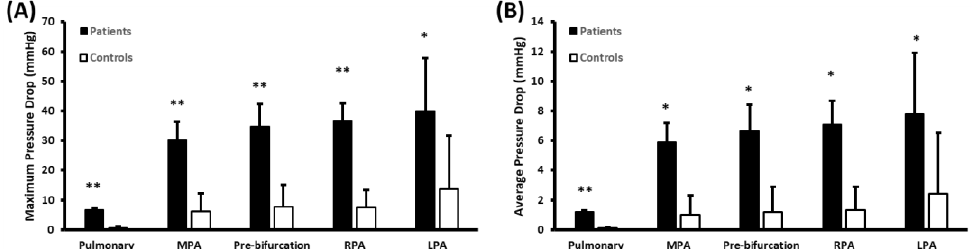
Figure 8. Pressure drops along the pulmonary artery. Pulmonary valve, main pulmonary artery (MPA), pre-bifurcation, right pulmonary artery (RPA), and left pulmonary artery (LPA). The right ventricular outflow tract was used as the reference plane location. Panel ( A ) shows the assessment of maximum pressure drop (PD). Panel ( B ) shows the average PD. * indicates p - value ≤ 0.05 between rTOF patients and controls. ** indicates p - value ≤ 0.001 between rTOF patients and controls.